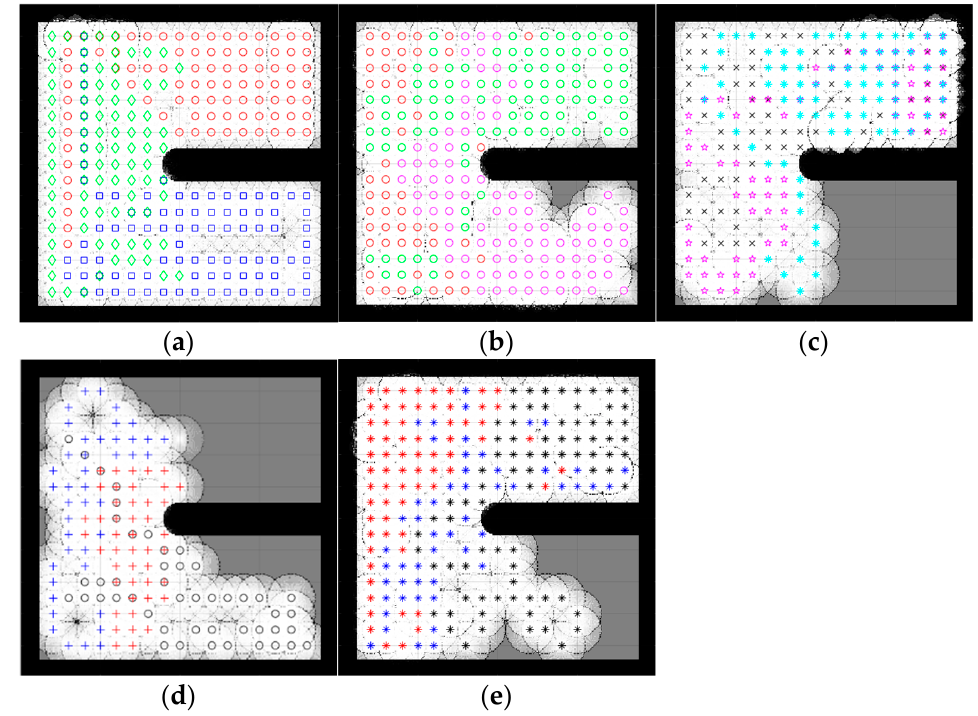
Figure 6. Percentage of the explored area after implementing the CME-SSA and the other approaches on simple map 2. Simple map 2: ( a ) CME 97%, ( b ) CME-SSA 92%, ( c ) CME-GWO 72%, ( d ) CME-GWOSSA 61%, ( e ) CME-SCA 74%.